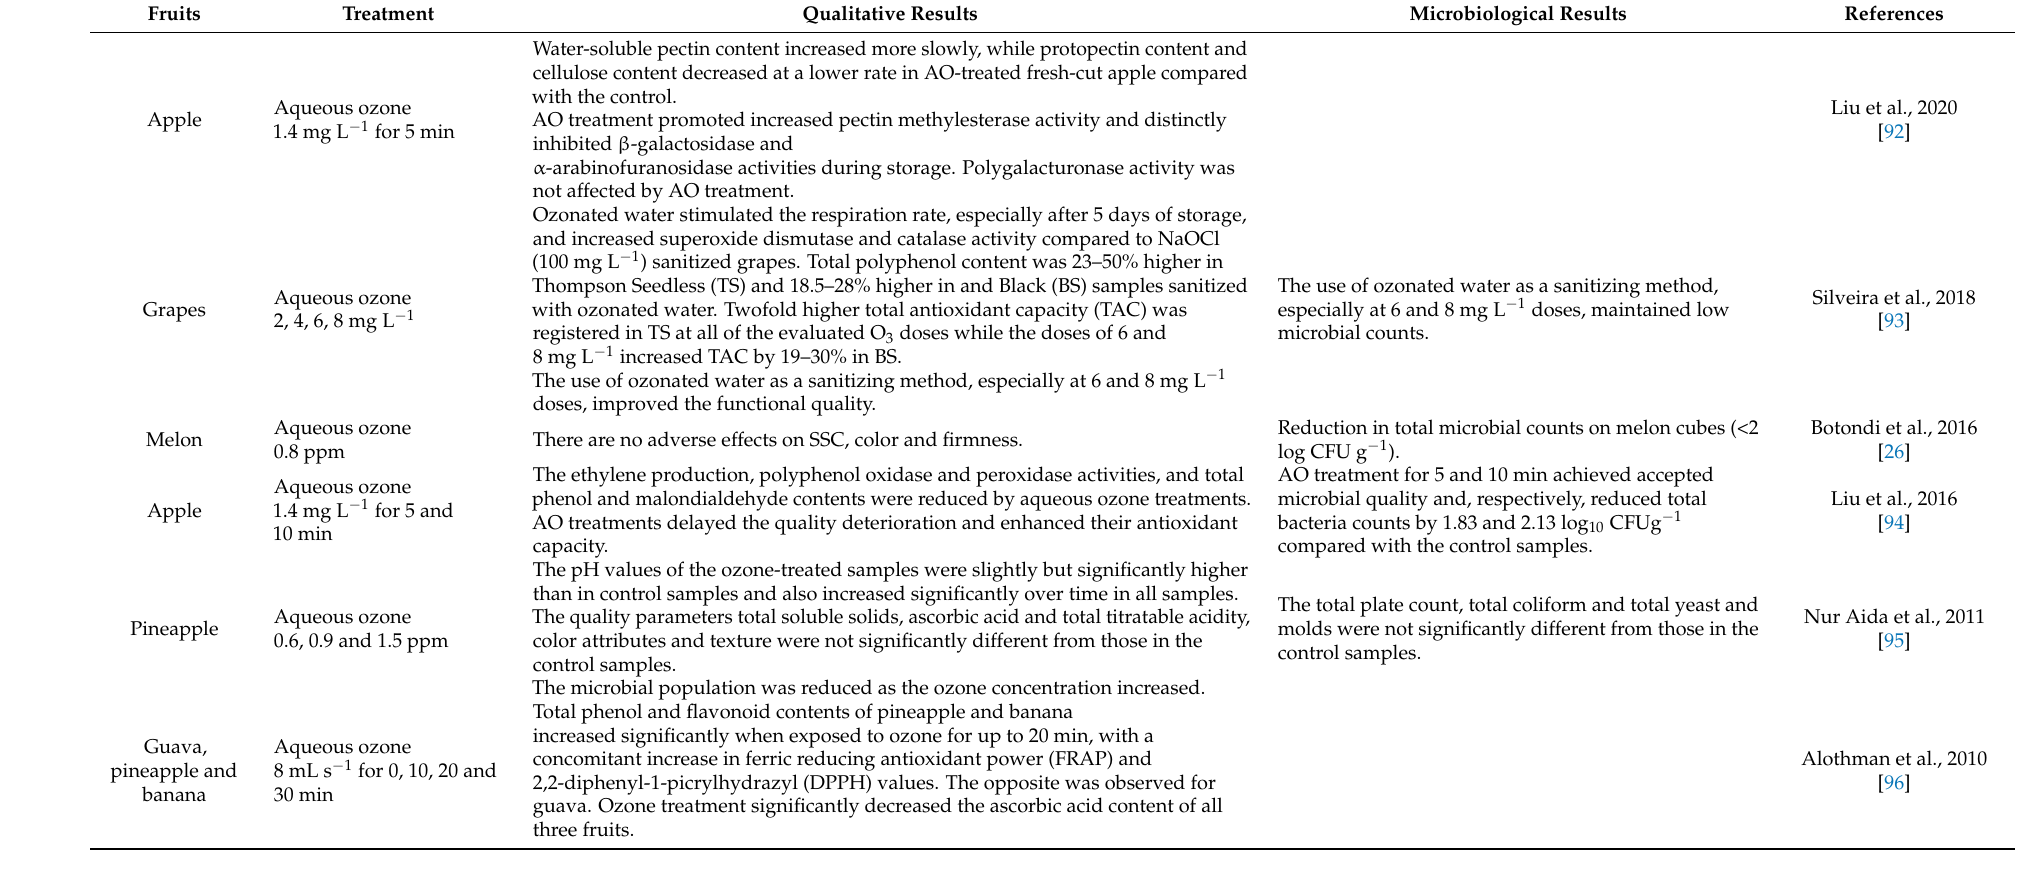
Table 2. Effect on the quality parameters and microbiological control of fresh-cut fruits treated with aqueous